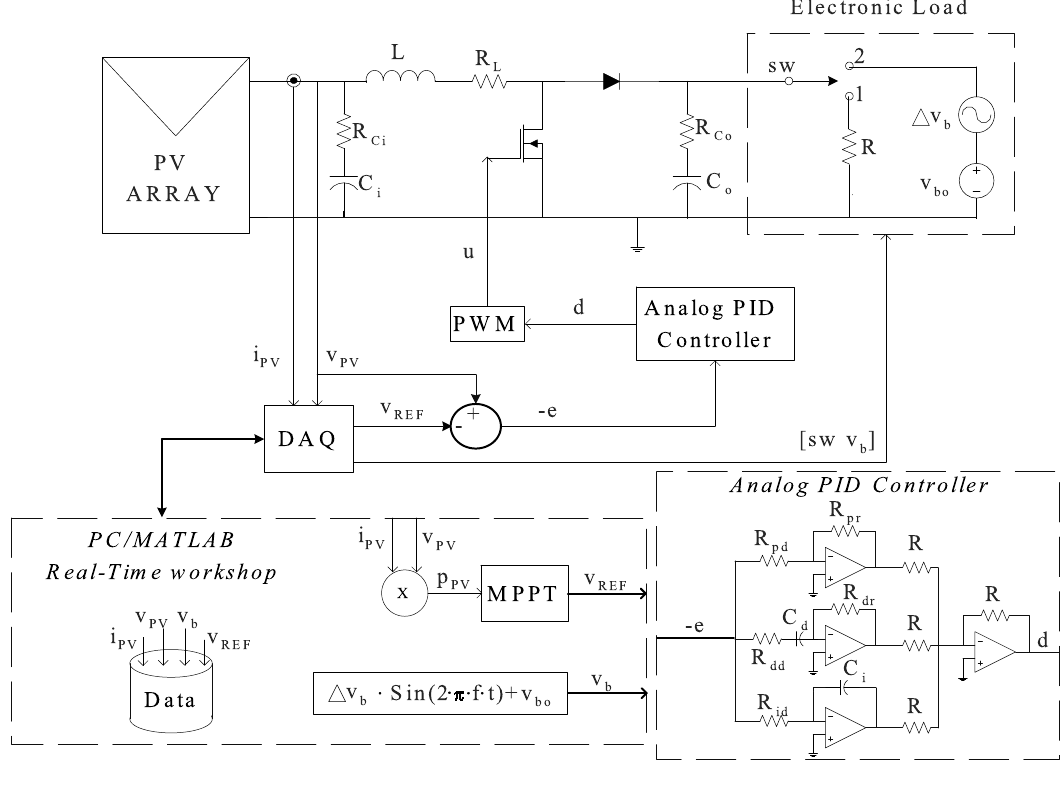
Figure 17. Implementation scheme for the experimental tests.